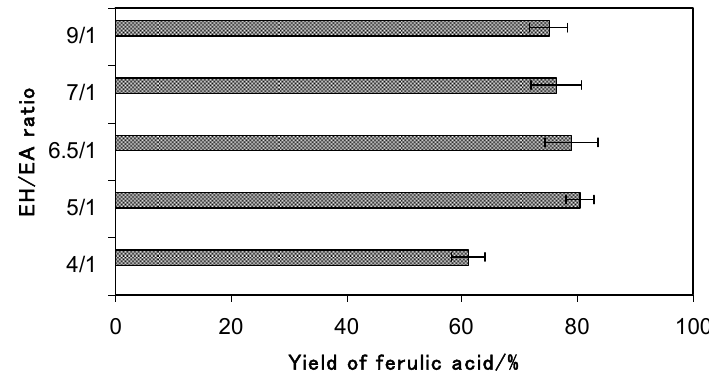
Figure 4. Effect of ethanol/ethyl acetate ( v / v ) (EH/EA) ratio on yield of FA.